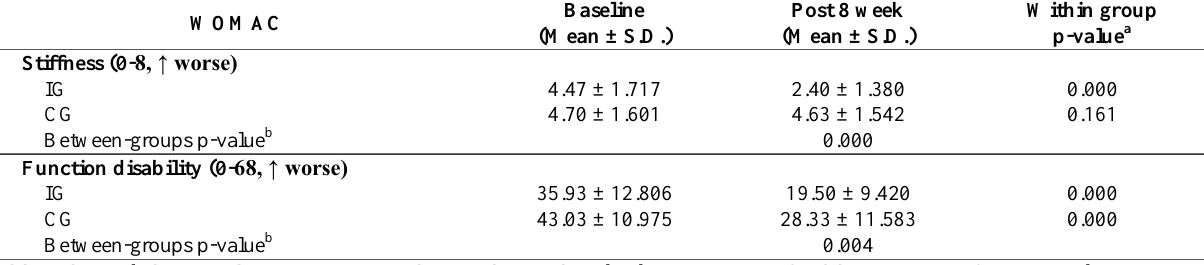
Table 2. Comparison of the Mean Change in the WOMAC Subscale Among Intervention and Control Groups from Baseline to Post an Eight